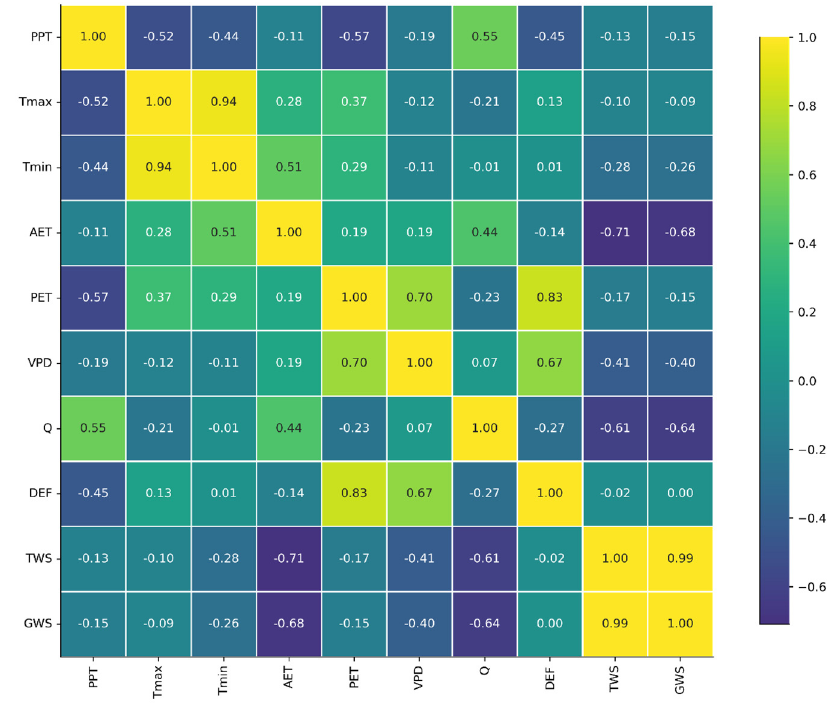
Figure 12. Pearson correlation map of 2020 in Ethiopia.